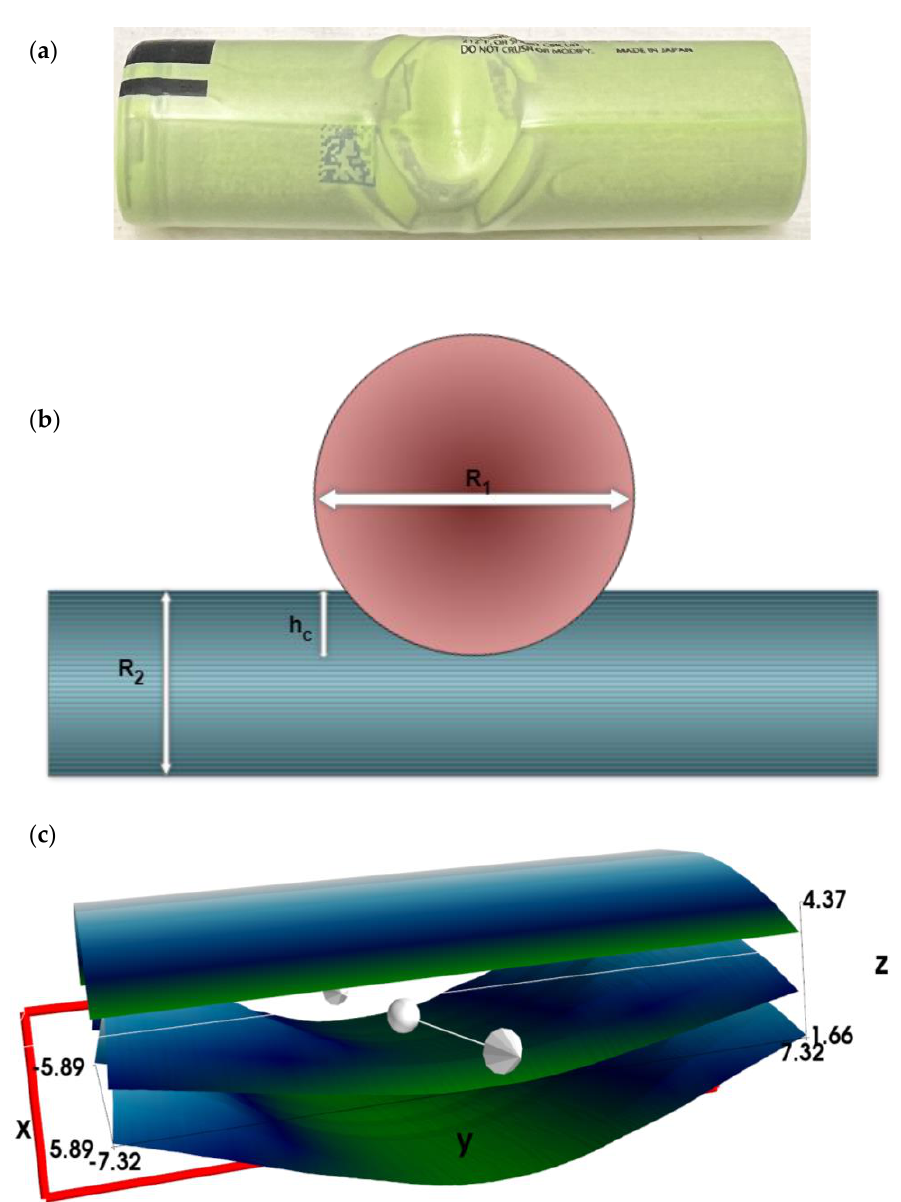
Figure 3. ( a ) Deformed LIB cell through the indentation test, ( b ) Schematic of a cylindrical LIB cell being indented by a rigid cylindrical indenter, ( c ) Graphical representation of fitting an ellipsoidal cap to the deformed surface.